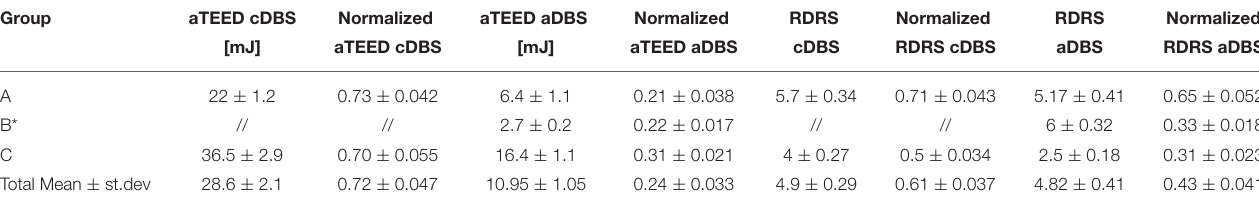
TABLE 2 | Patient’s clinical assessments. Group aTEED cDBS Normalized aTEED aDBS Normalized RDRS Normalized RDRS Normalized [mJ] aTEED cDBS [mJ] aTEED aDBS cDBS RDRS cDBS